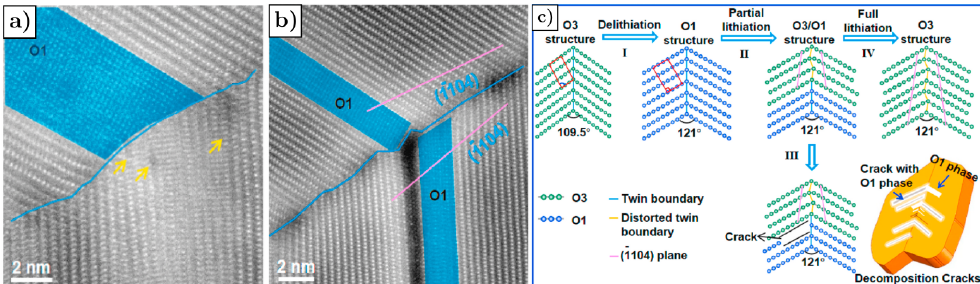
Figure 30. Phase transition induced cracking at the twin boundary. ( a ) A STEM-HAADF image showing the O1 phase (light blue region) formed at the highly distorted twin boundary, indicated by the light blue line. Incubation cracks at the twin boundary are marked by yellow arrows. ( b ) De- composition crack formed along an O1 phase strip. ( c ) Schematic diagrams illustrating the cracking mechanism induced by phase transition at the twin boundary. Reprinted with permission by Elsevier from [136], Copyright 2020.